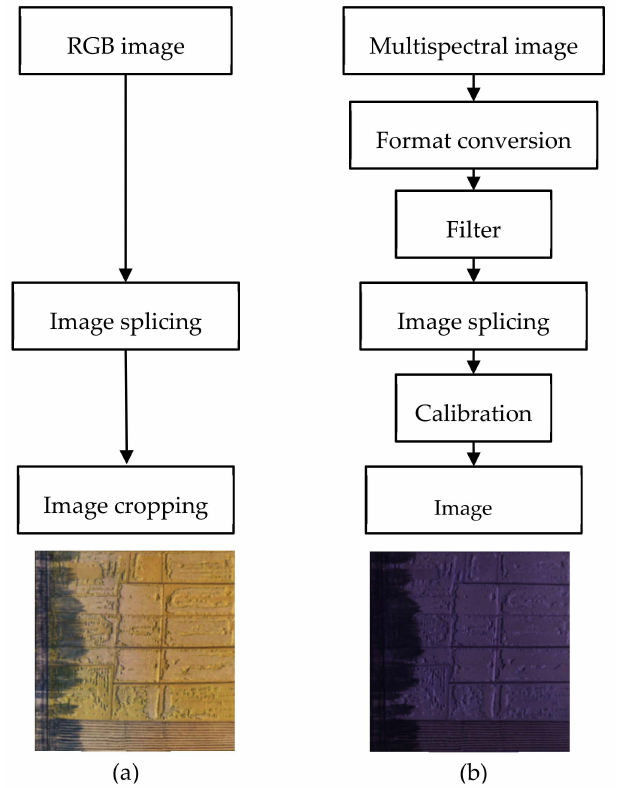
Figure 2. Data preprocessing: ( a ) the resulting RGB image; ( b ) the resulting multispectral